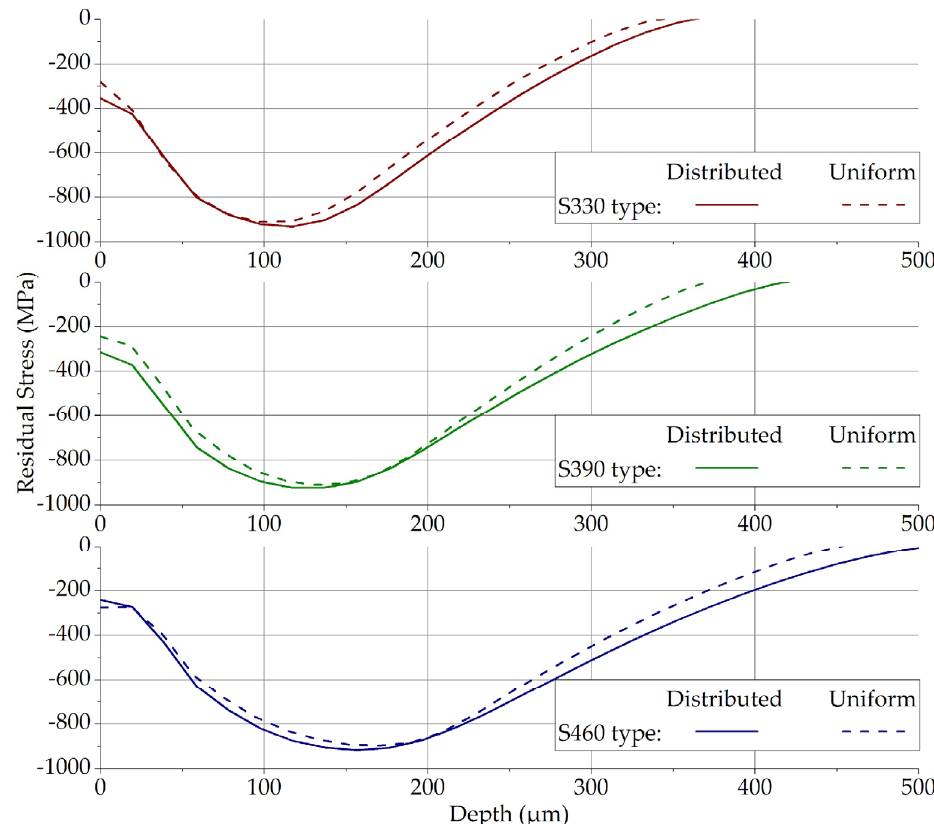
Figure 11. Comparison of residual stress profiles for three different shot types considering constant and variable shot